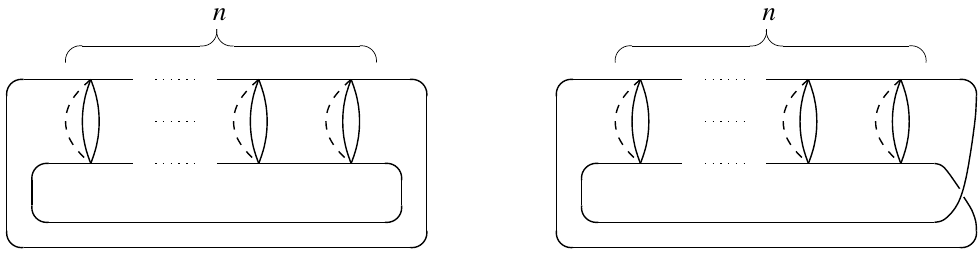
Figure 6 . NLO contributions with n rungs, without (left) and with (right)